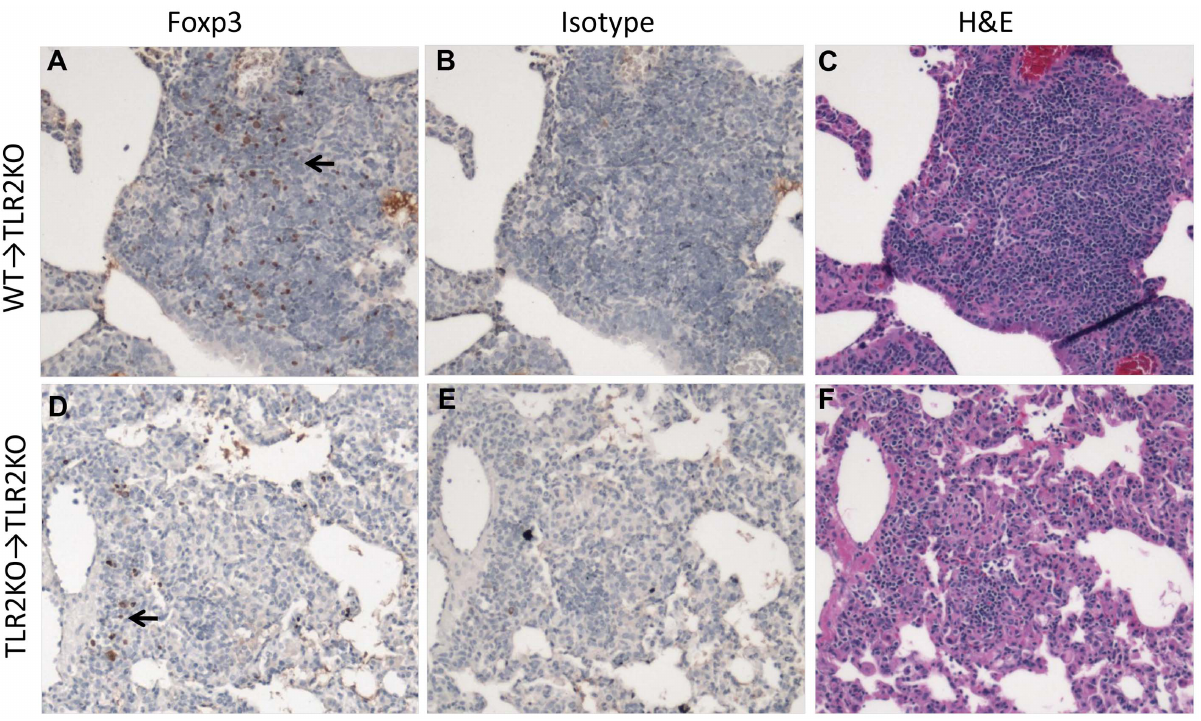
Figure 7. Histological evaluation displays increased accumulation of Tregs in WT R TLR2KO hosts is associated with reduced inflammation. Formalin-fixed, paraffin-embedded lung tissue was obtained at 7 weeks post-Mtb infection. Serial sections showing areas of granulomatous inflammation in WT R TLR2KO (A–C) and TLR2KO R TLR2KO (D–F) mice are shown. Sections were stained with anti-Foxp3 (A and D), isotype control (B and E), or H&E (C and F). Brown pinpoint staining indicative of Foxp3 + staining was not observed in serial sections stained with isotype control. Photomicrographs were taken at a 10 6 magnification (A–F). Representative sections are shown.